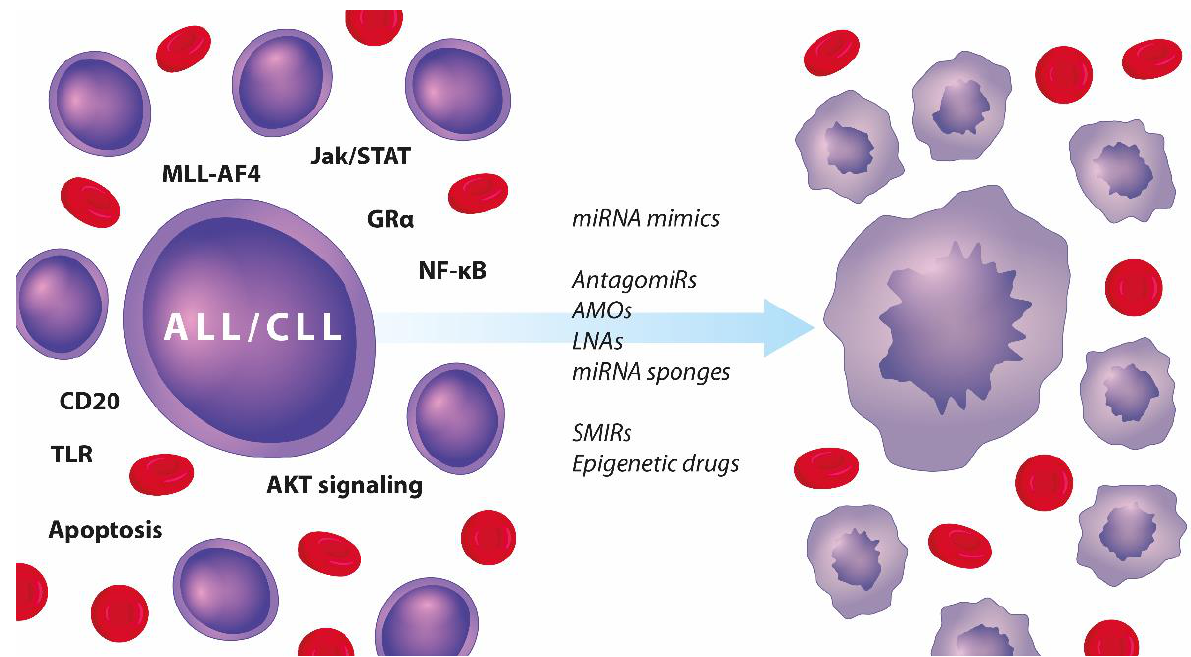
Figure 5. Summary of therapeutic approaches to targeting the miRror in adult and paediatric ALL and CLL.